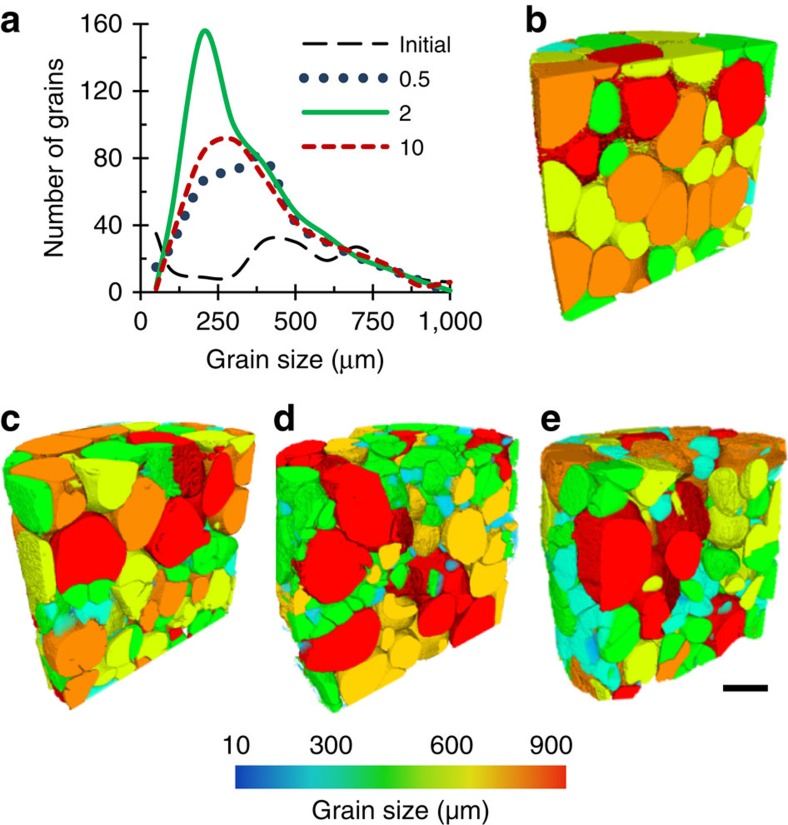
Log-normal distribution of cracked grains.(a) Grain size distribution of initial and final Al–Cu microstructures after semi-solid indentation at various indentation speeds (units: μm s−1). 3D rendering of solid grains, coloured by size, at (b) the initial state for the 0.5 μm s−1 indentation speed and at the final states for the (c) 0.5, (d) 2 and (e) 10 μm s−1 indentation speeds, respectively. Scale bar, 750 μm.